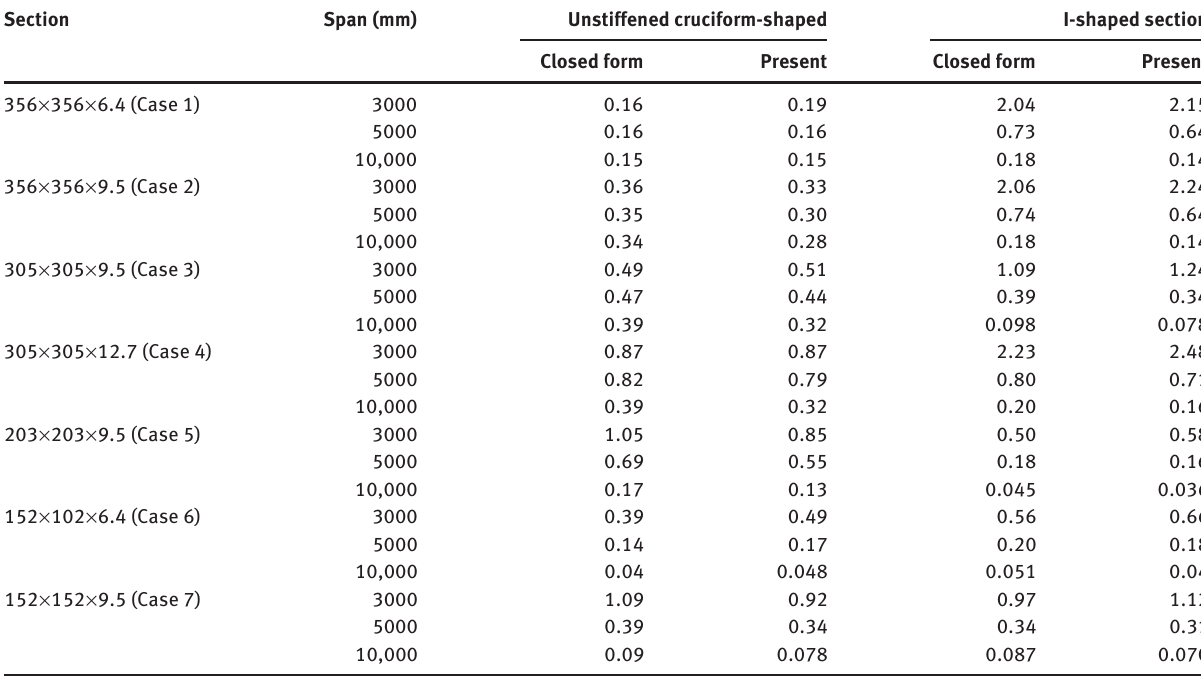
Table 8 Comparisons normalized buckling stresses of FRP unstiffened cruciform- and I-shaped section beams. Section